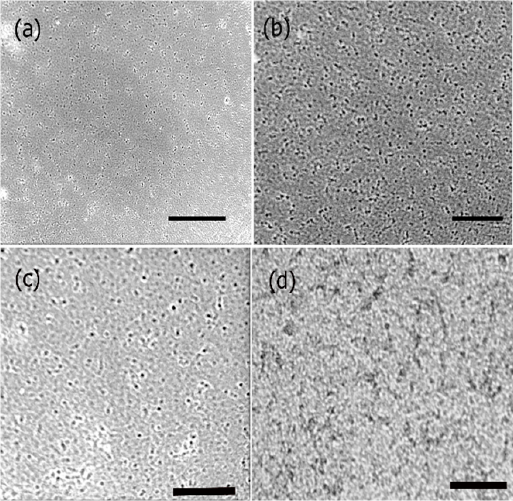
Figure 11. Phase contrast microscopy images showing the growth of neural cortical cells ( a ) control cells after 24 h; ( b ) control cells after 72 h; ( c ) cells with PANI bound scaffolds after 48 h and ( d ) cells with PANI bound scaffolds after 7 days. Scale bars: ( a ) 50 μ m; ( b ) 50 μ m; ( c ) 30 μ m; ( d ) 50 μ m.